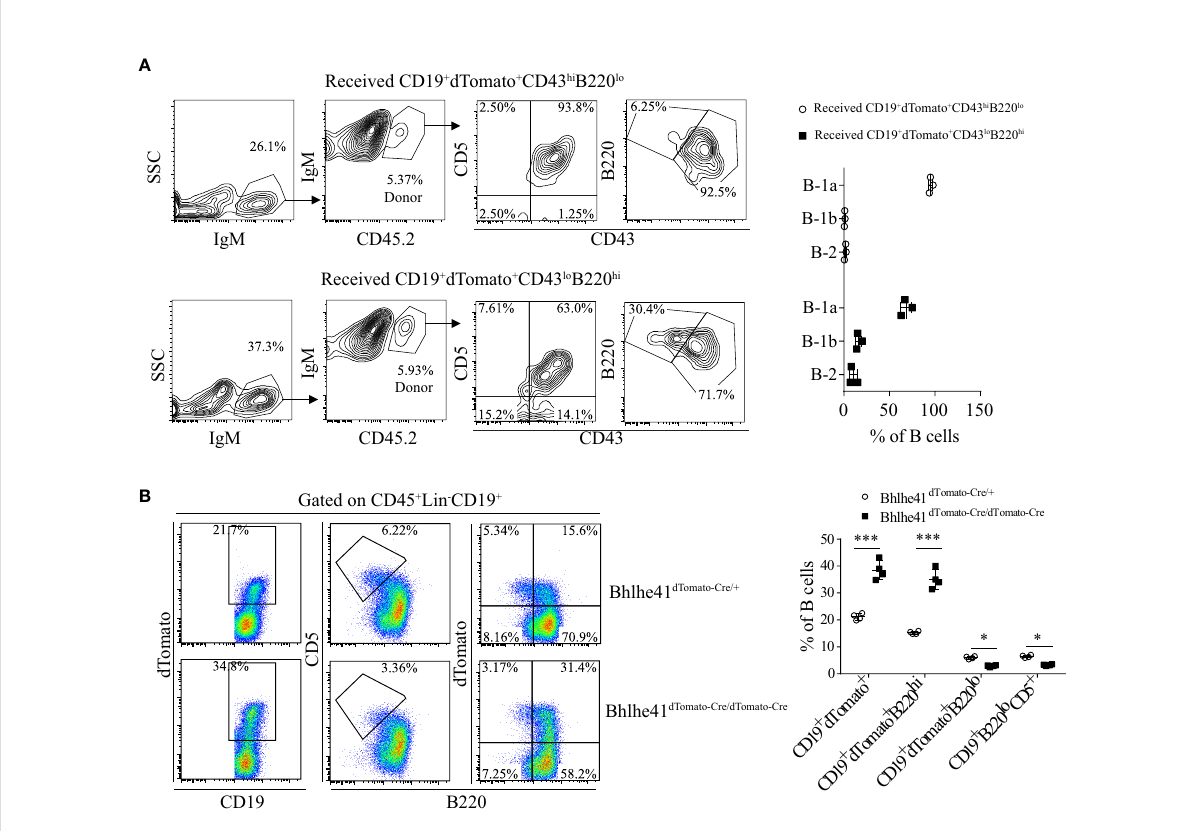
FIGURE 7 Identi fi cation of CD19 + dTomato + B220 hi CD43 lo B cells as novel transitional B-1 progenitors. (A) Splenic CD19 + dTomato + B220 hi CD43 lo and CD19 + dTomato + B220 lo CD43 hi B cells were puri fi ed from neonatal Bhlhe41 dTomato-Cre mice at postnatal day 7 and i.p. adoptively transferred to 3-week B6.SJL recipient mice. Flow cytometric analysis of peritoneal B cells in B6.SJL recipient mice 5 days after transfer. (B) Flow cytometric analysis of splenic B cells from Bhlhe41 dTomato-Cre and Bhlhe41 dTomato-Cre/dTomato-Cre mice at postnatal day 7. Differences between two groups for each cell type were analyzed by Student ’ s t-test. * P < 0.05, *** P <